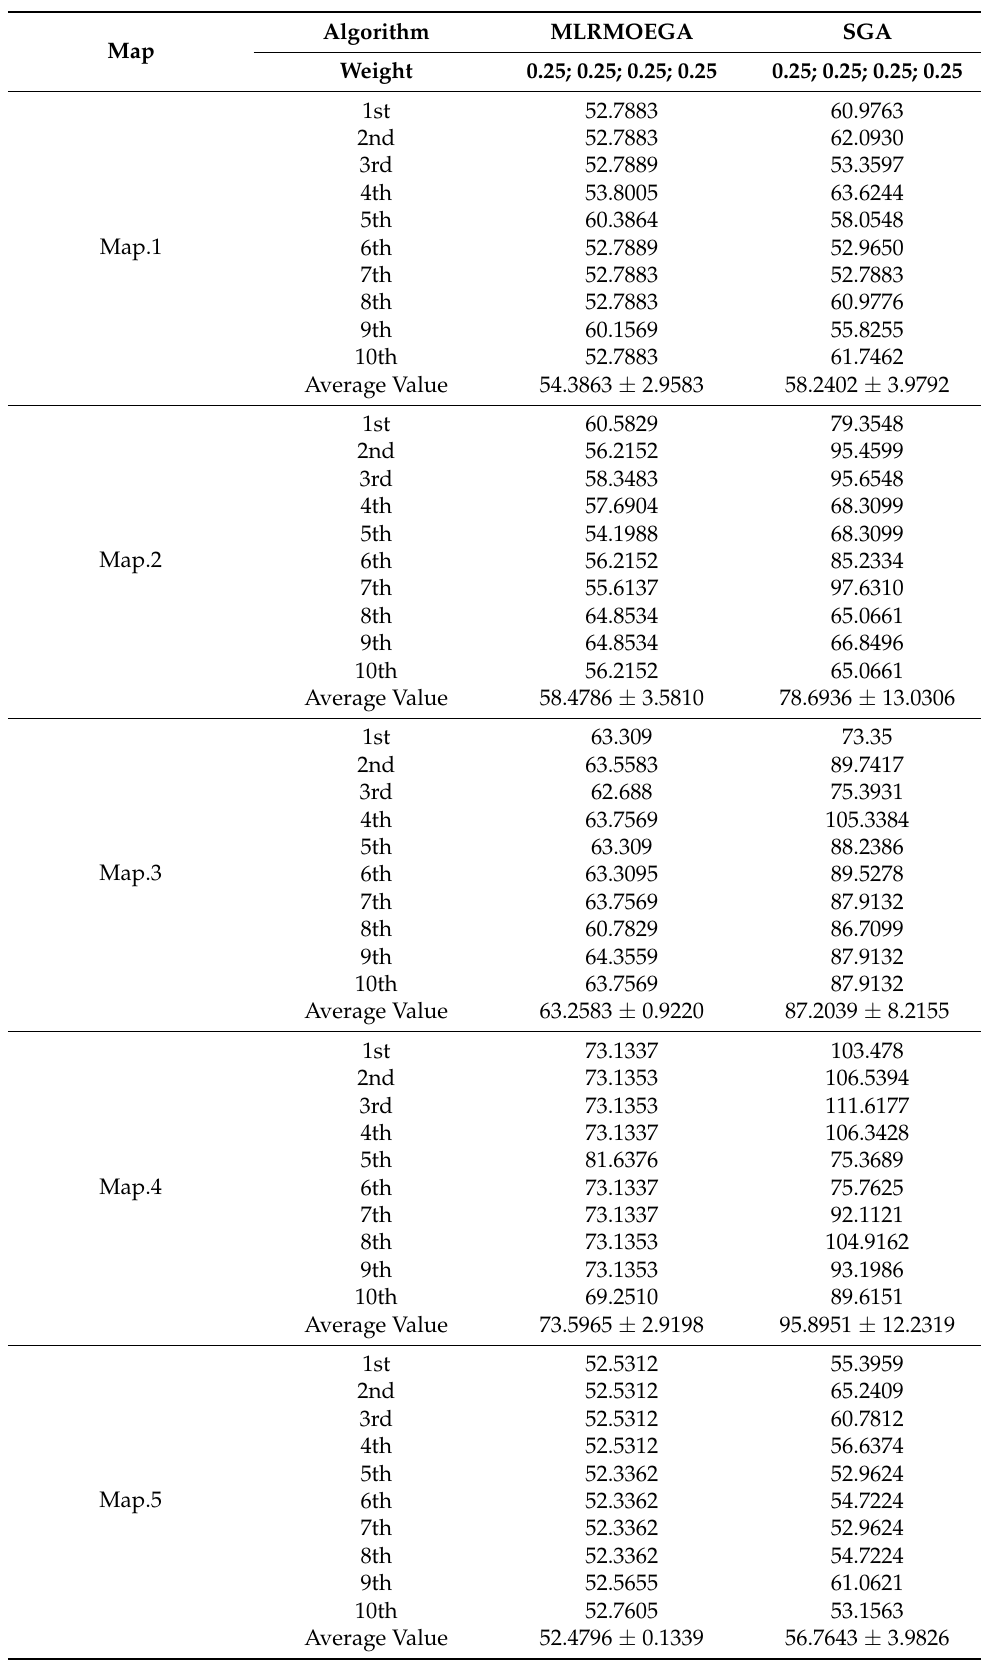
Table 8. The results of 5 other tests (20 × 20 grid